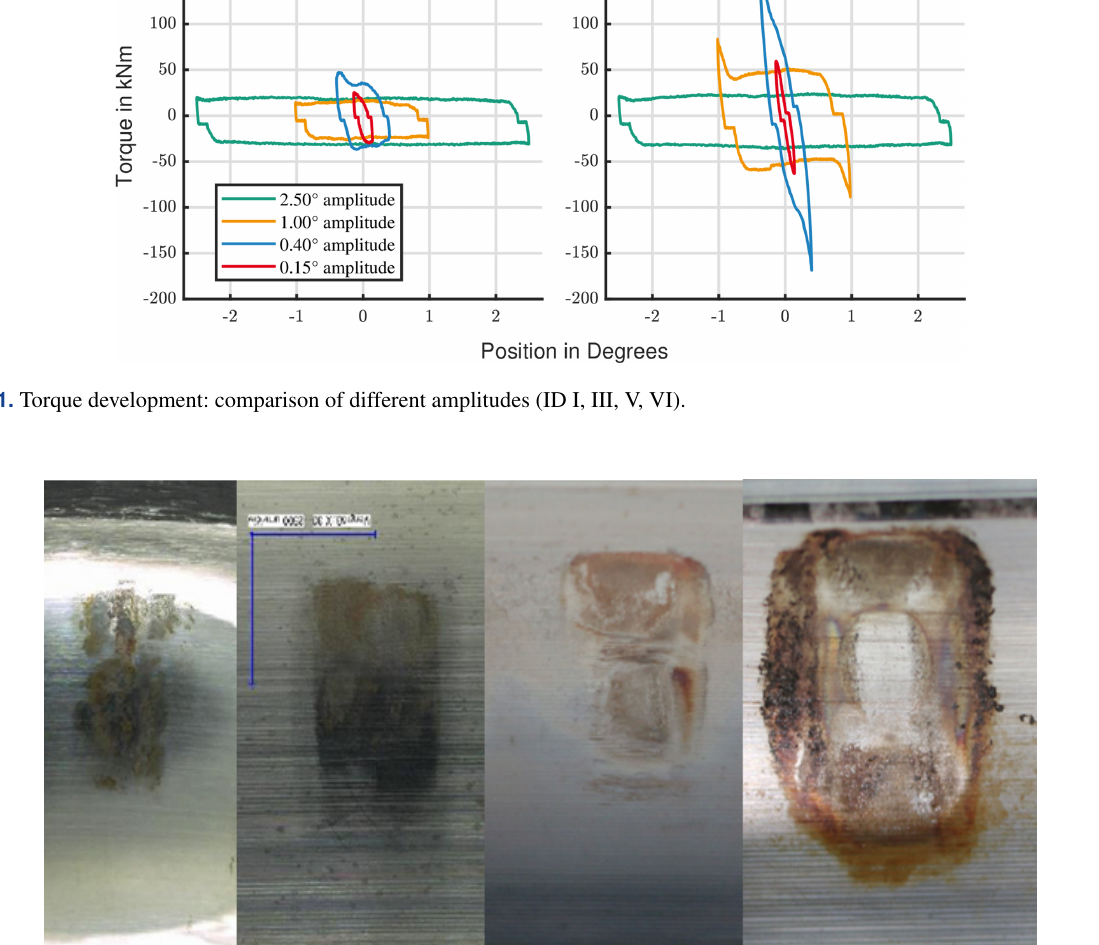
https://doi.org/10.5194/wes-8-289-2023 Wind Energ. Sci., 8, 289–301,